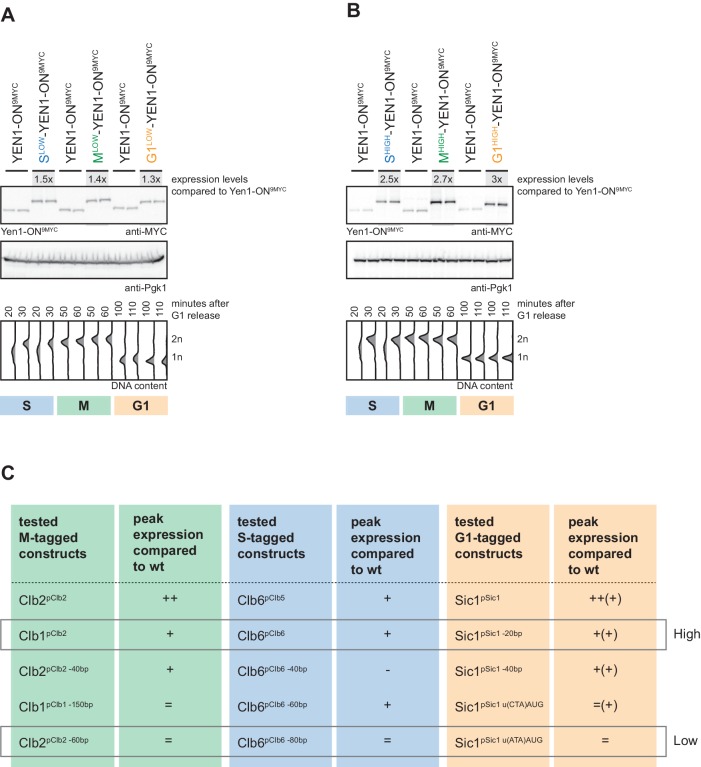
Analysis of ‘low’ and ‘high’ S-, M- and G1-tagged Yen1-ON peak expression levels.(A/B) Sets of Slow (Clb6pClb6 -80bp)-, Mlow (Clb2pClb2 -60bp)- and G1low (Sic1pSic1 u(ATA)ATG)-Yen1-ON (A) and Shigh (Clb6pClb6)-, Mhigh (Clb2pClb1)- and G1high (Sic1pSic1 -20bp)-Yen1-ON (B) display similar peak expression levels in S, M and G1 phase, respectively. Western blot analysis of peak expression levels of cell cycle-tagged Yen1-ON-9MYC variants at individual time points after G1 release (20,30 min = S; 50,60 min = M; 100,110 = G1) as controlled by DNA content measurement by flow cytometry (lower). Peak expression levels were quantified using Image-J and signals of the individual constructs were divided by the corresponding Pgk1 sample to normalize to overall protein levels. Normalized peak expression levels were compared to WT expression at the corresponding time point (fold difference) and the two analysed time points were averaged for each construct to result in a mean fold difference that is indicated above the western blots. (C) Summary of peak expression levels of various tested cell cycle-tagged Yen1-ON constructs. Depicted are relations of peak expression values in comparison to WT, which lead to selection of ‘high’ and ‘low’ expressing constructs.